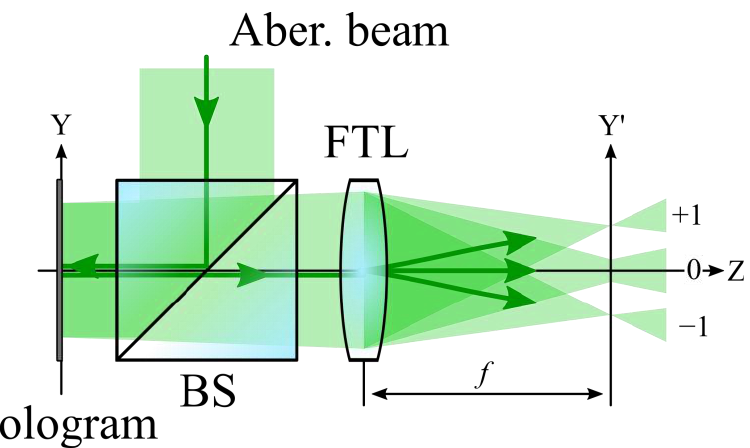
Figure 1. Principle of CGH operation with multiple orders of diffraction.